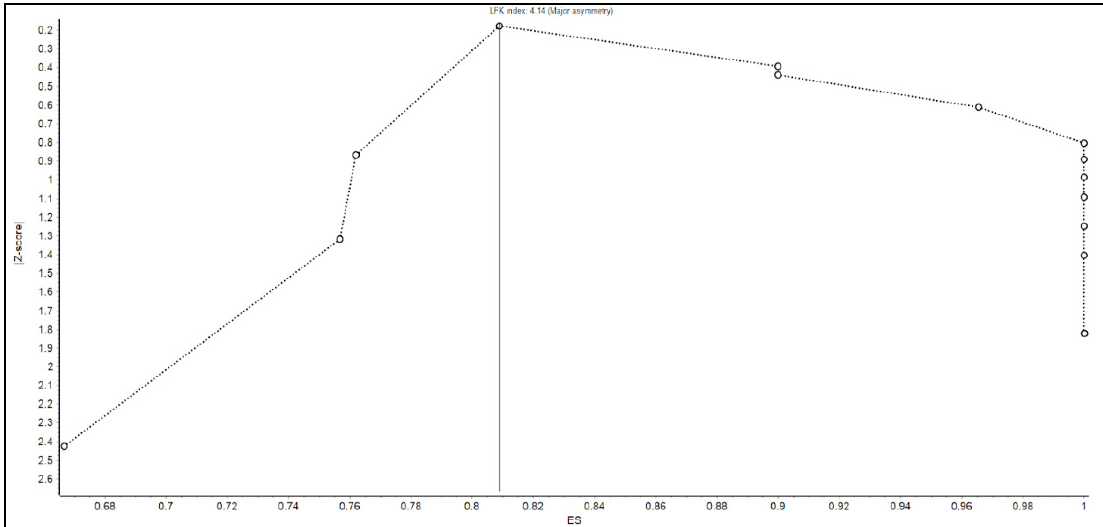
Figure 5. Doi plot for assessing the evidence of publication bias .